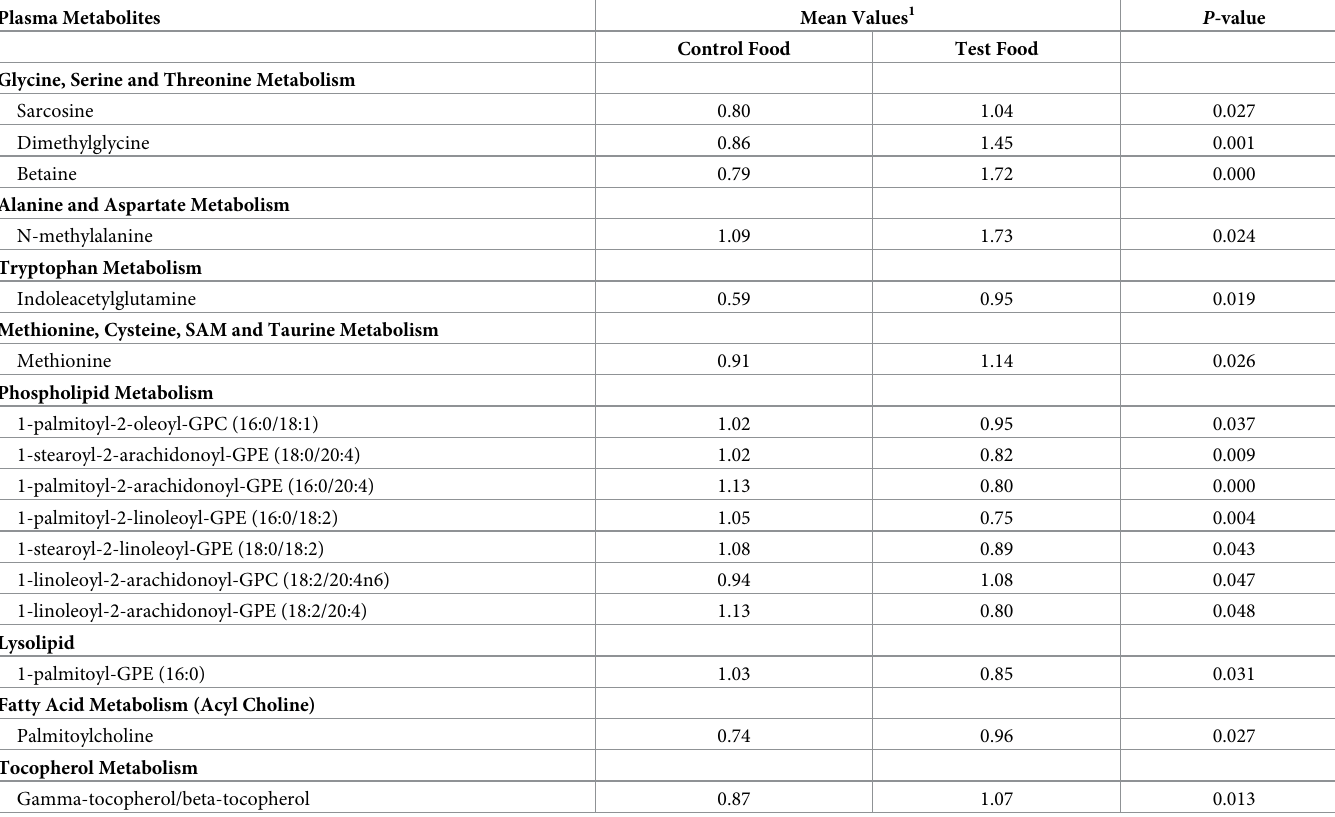
Table 4. Relative concentrations of plasma metabolites that were significantly different ( P � 0.05) in cats (N = 7) with Chronic Kidney Disease (CKD) after feeding control food or test food for 8 weeks in a crossover feeding trial. Plasma